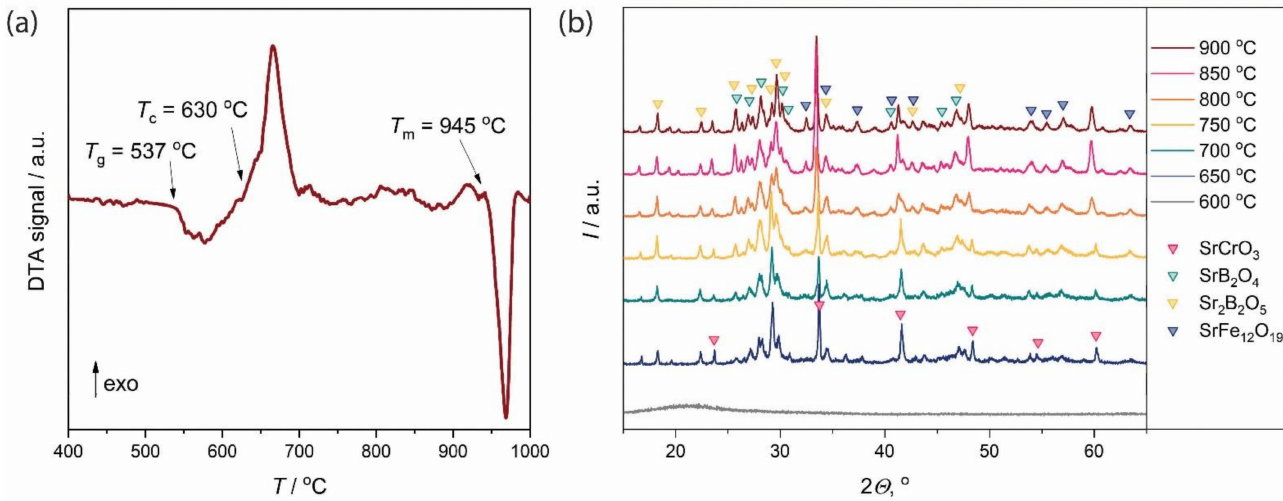
Figure 1. ( a ) DTA curve of the SrFe 8 Cr 4 O 19 –12Sr 2 B 2 O 5 glass; ( b ) XRD patterns of the glass-ceramics. The annealing temperatures and observed phases are denoted on the